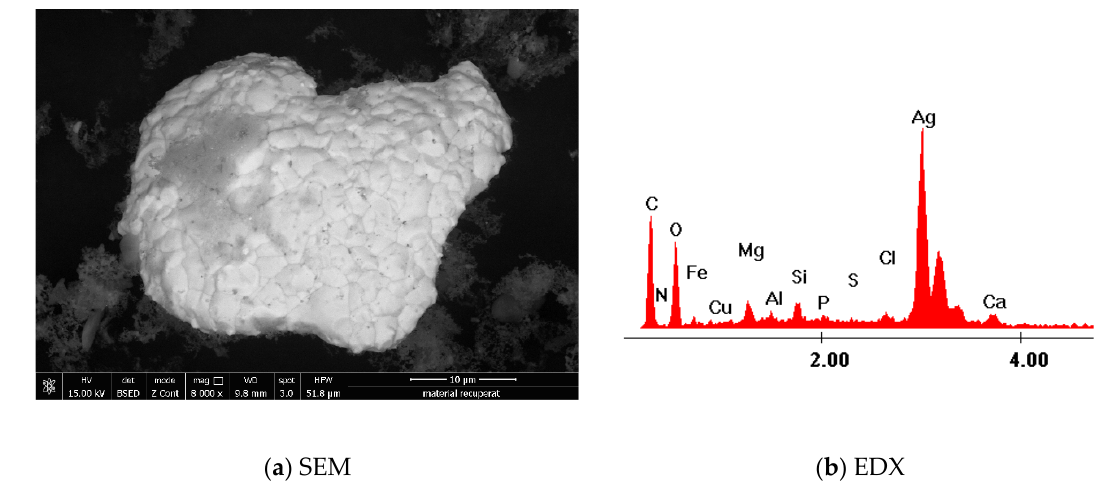
Figure 11. Scanning electron microscopy and X-ray energy dispersion in order to highlight the obtaining of metallic silver ( a ) SEM; ( b )